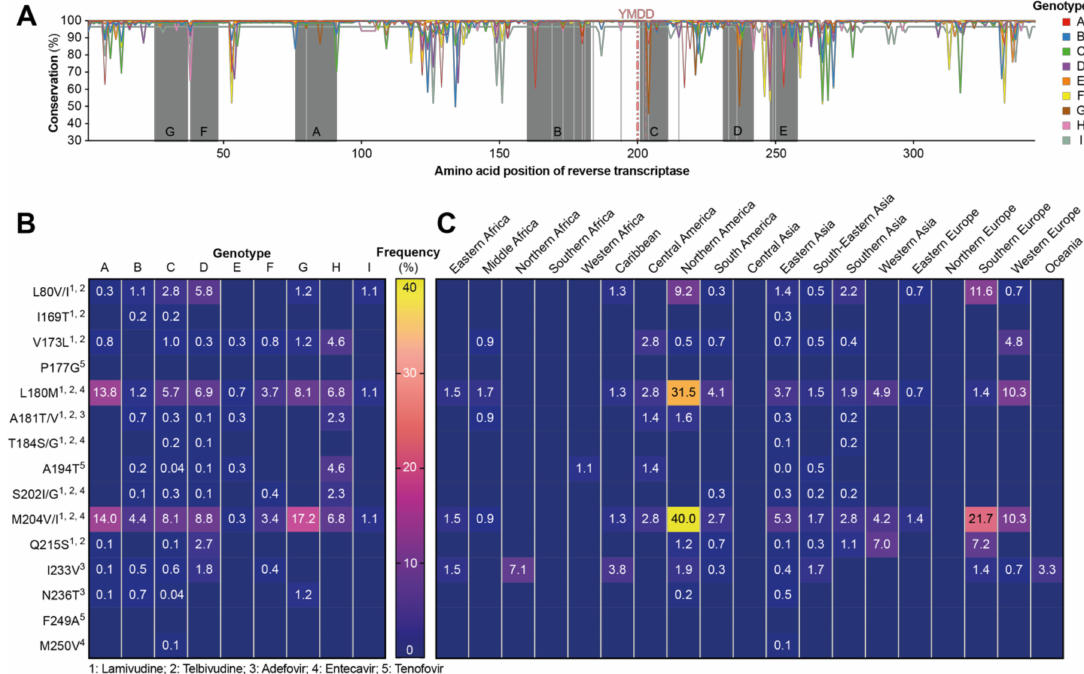
Figure 4. Frequency of mutations in the reverse transcriptase associated with resistance to nucleoside analogues. ( A ) Conservation of the reverse transcriptase (RT) part of the HBV polymerase within genotypes as determined using the consensus sequence of each genotype as a reference. The di ff erent domains (A–G) of the RT are highlighted by underlying gray color. Vertical light gray lines indicate positions at which resistance mutations occur. ( B , C ) Numbers in the table indicate percentage of sequences containing the respective mutation within ( B ) each genotype or ( C ) the di ff erent world regions. Blue fields without numbers represent a value of 0.0%. Superscript numbers indicate the clinical finding, which has been associated with the respective